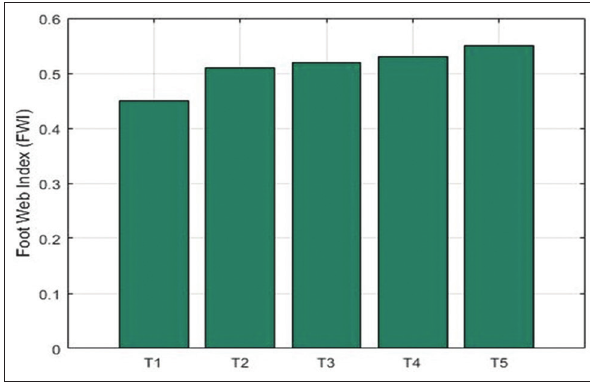
Figure-1: Cell-mediated immune response to phytohemagglutinin-P (mm) in broilers under different dietary treatment.